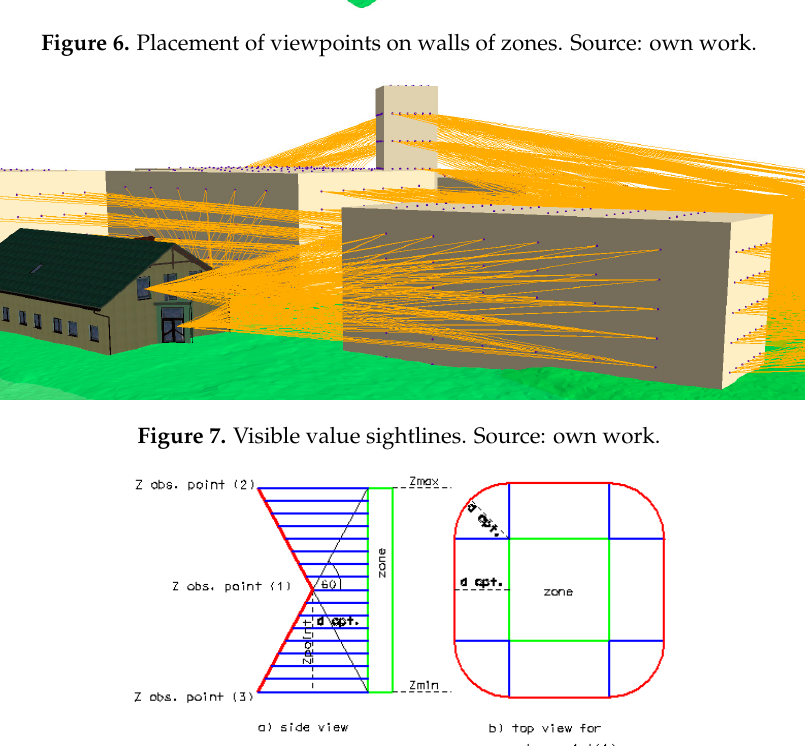
Figure 8. Optimal distance for any zone. Source: own work